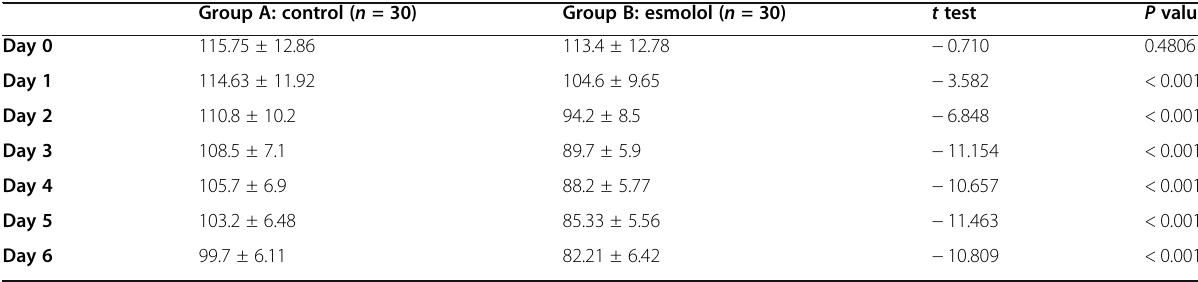
Table 5 Comparison between both groups according to heart rate